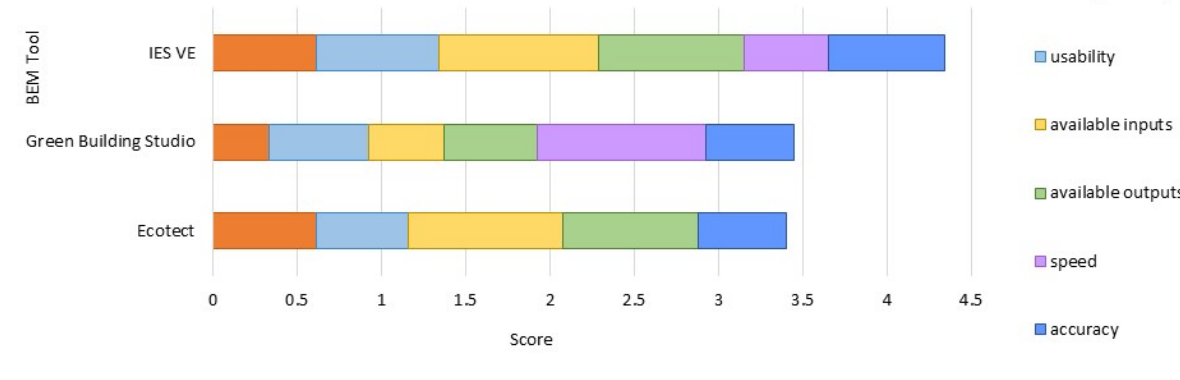
Figure 5. Re-evaluation scores